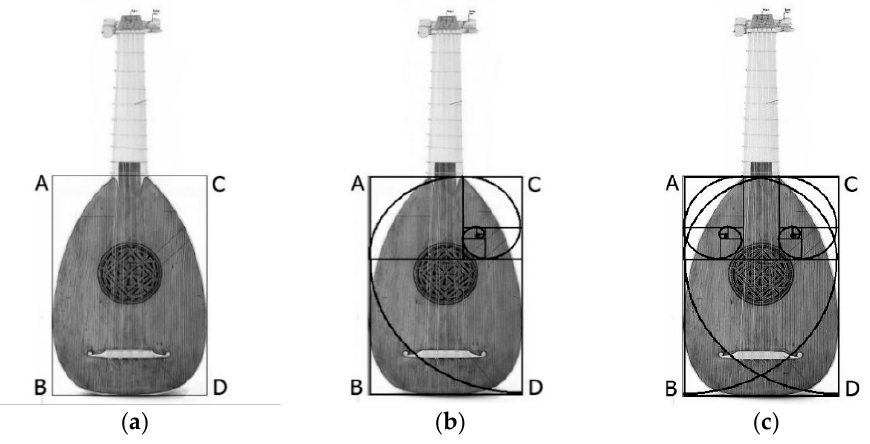
Figure 3. ( a ) Step one: tangential rectangle, ( b ) step two: the first golden spiral, ( c ) step three: the second golden spiral.